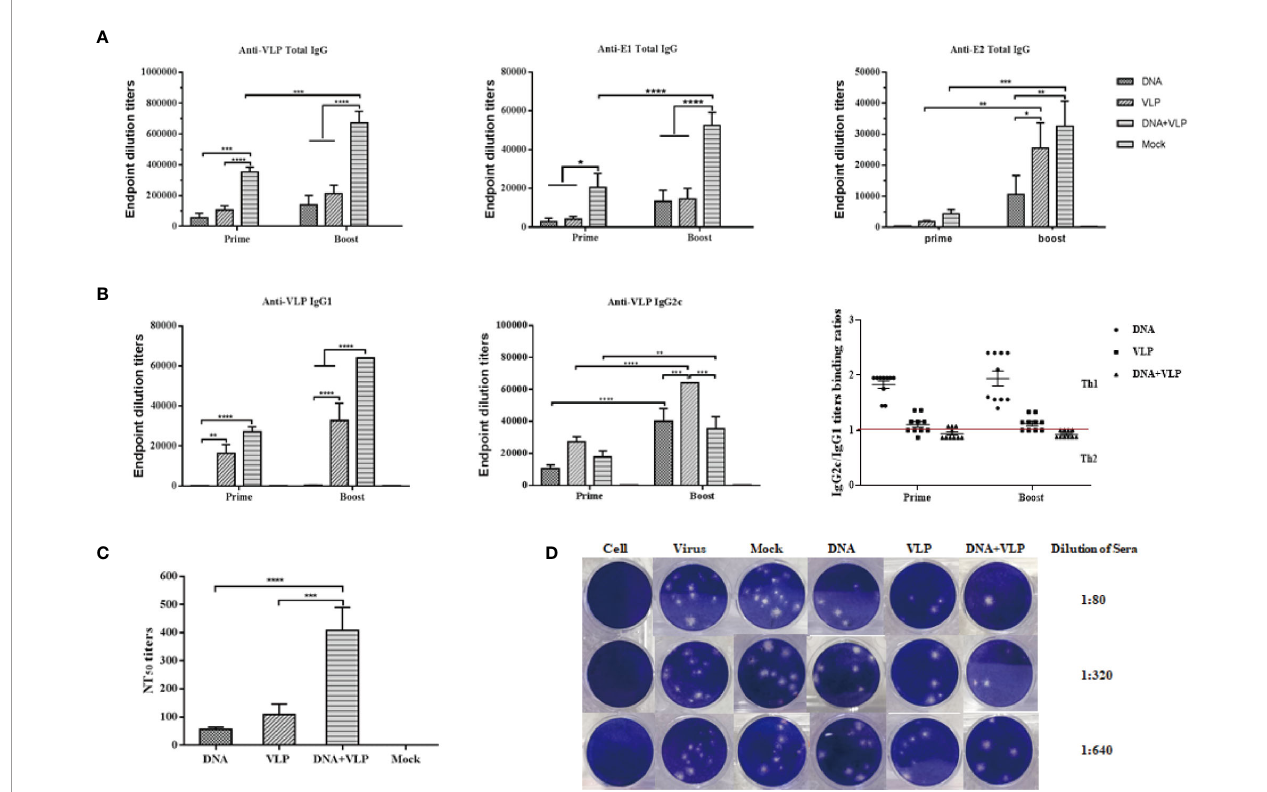
FIGURE 4 | Co-immunization-induced broad CHIKV antigen-speci fi c IgG antibody responses and high cross-neutralization antibody response in mice. Anti CHIKV VLP, E1 and E2 antibody measurement by ELISA. Sera were collected at day 14 and 35 after the prime and boost immunization and total IgG produced was measured in each group (A) . IgG subtype ELISA analysis. The graph shows VLP speci fi c IgG1 and IgG2c antibody levels in mice, IgG2c/IgG1 binding ratios are shown for mice immunized with DNA, VLP or DNA+VLP (B) . Neutralizing antibody titers against CHIKV Ross were determined by plaque reduction neutralization assays at day 35 (C) . Representative results of the plaque reduction neutralization (PRNT) assay for the detection of neutralization activity in the sera of mice (D) . Approximately 10-15 pfu of the virus stock (CHIKV Ross) was used to infect Vero cells in 12-well plates with heat-inactivated sera from immunized mice 14 days after the boost immunization. PRNT 50 was calculated after the plaques were counted. Data are from one experiment of three independent experiments and presented as the mean ± SEM (n=10). The statistical analysis among groups analyzed by two-way analysis of variance (ANOVA) and Tukey multiple comparison tests, ****p<0.0001, ***p<0.001, **p<0.01,